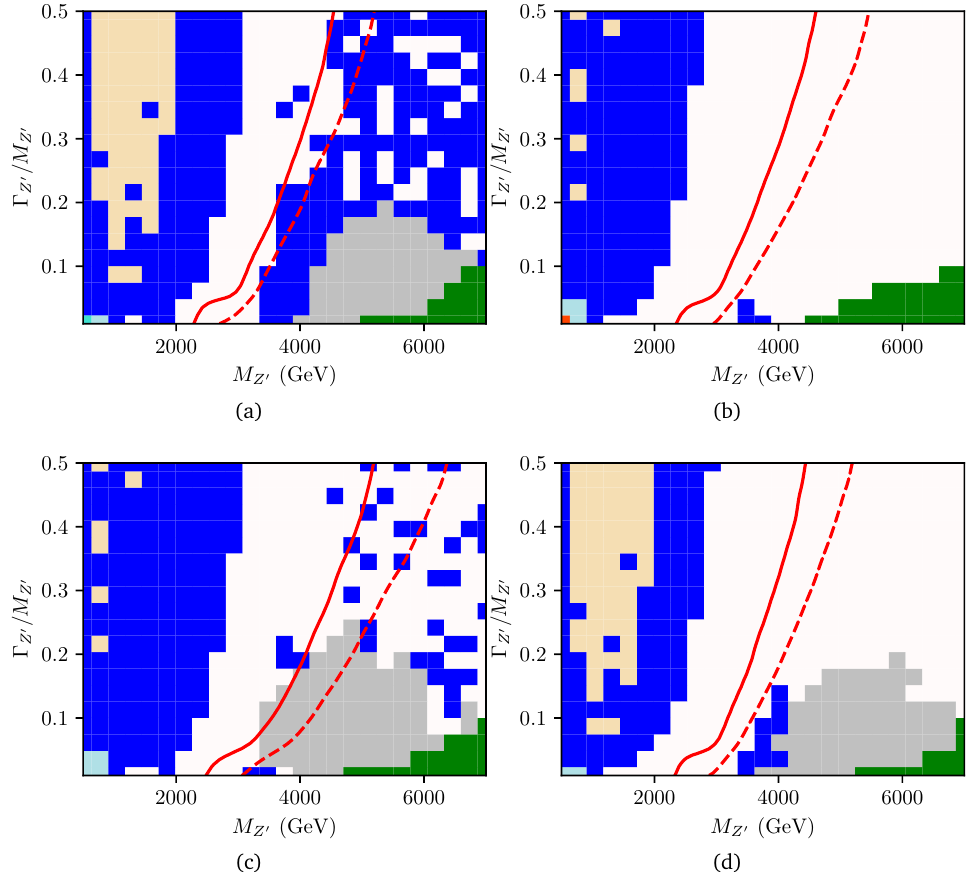
Figure 2: Sensitivity to the leptophobic TC model, in the Z ′ mass (GeV) versus Γ / M plane, for Z ′ → t ¯ t . The coloured blocks indicate the most sensitive final Z ′ Z ′ state (see legend below). The 95% CL (solid red) and 68% CL exclusion (dashed red) contours are superimposed. (a) Data used as background, but only those mea- surements with available SM predictions are used. (b) Using NLO SM prediction for background. (c) Using NNLO SM prediction for background. (d) Expected limit us- ing NNLO SM prediction for